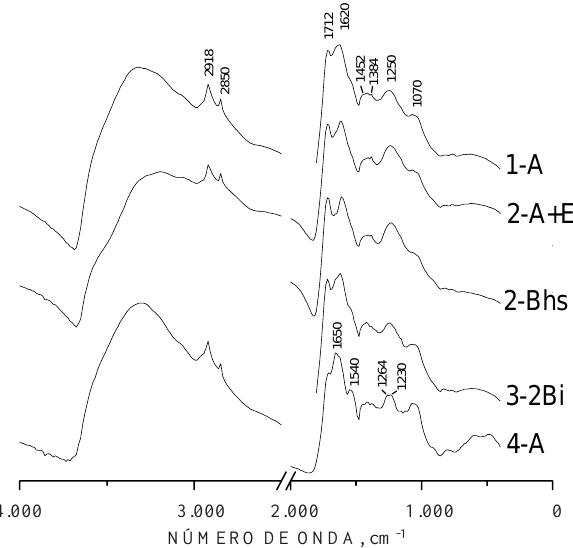
Figura 3. Espectros de absorção no infravermelho de ácidos húmicos purificados, extraídos de um Neossolo Litólico (1-A), de um Espodossolo Ferrocárbico (2-A + E e 2-Bhs), de um Cambissolo Húmico (3-2Bi) e de um Latossolo Vermelho- Amarelo (4-A) da Serra do Brigadeiro. Os espectros estão dispostos de cima para baixo, de acordo com a posição do perfil de solo no transecto estudado e de acordo com a posição do horizonte no